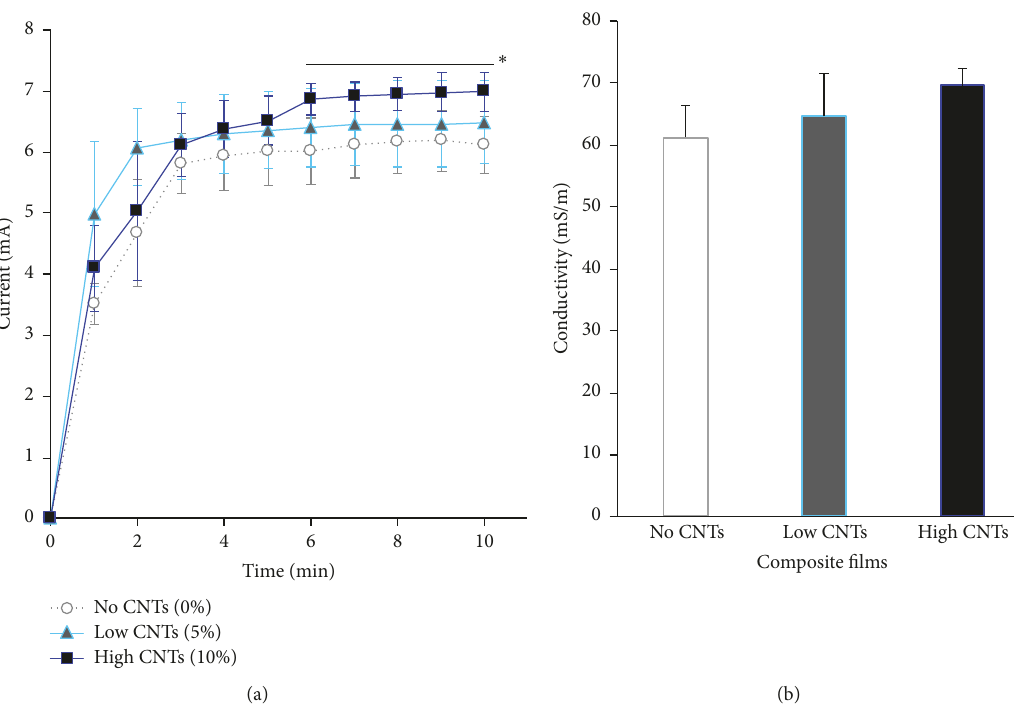
Figure 5: (a) Measured direct electrical currents (in mA) at constant voltage in composite films (no CNTs, low CNTs, and high CNTs groups) immersed in culture medium. ∗ 𝑝 < 0.05 for high CNTs versus low CNTs and no CNTs at currents from 6 to 10min time points (horizontal